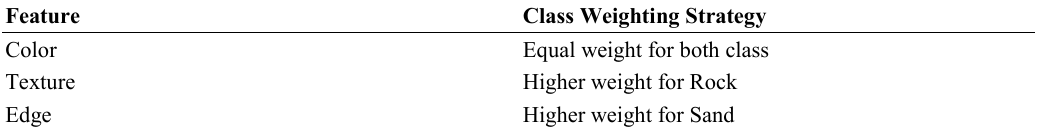
Table 1: Class weighting (i.e. cost of misclassification) strategy for different features to obtain diversity among the base classifiers in the ensemble.